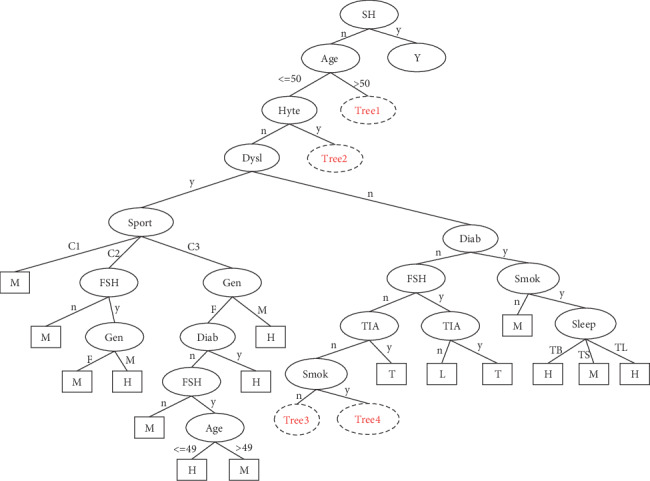
A decision tree to classify risk factors of stroke.